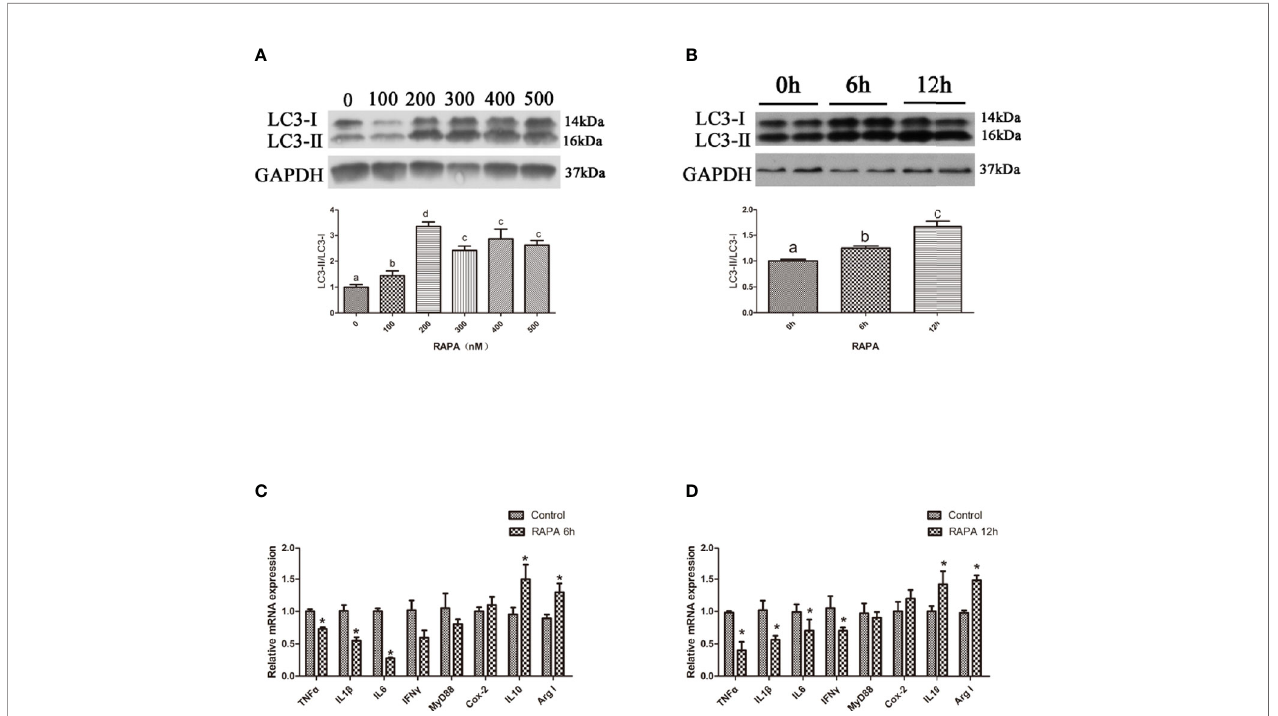
FIGURE 2 | Activation of autophagy could down-regulate the expression of in fl ammatory genes in vitro . (A) The ratio of LC3-II/LC3-I was analyzed by western blots in primary hepatocyte after treatment of different levels of RAPA (n=3). (B) The ratio of LC3-II/LC3-I was analyzed by western blots in primary hepatocyte after treatment of different time of RAPA (n=3). (C) The mRNA expressions of TNF a , IL1 b , IL6, IFN g , MyD88, Cox-2, IL10 and Arg I were analyzed by qRT-PCR in primary hepatocyte after treatment of 200 nM RAPA for 6h (n=6). (D) The mRNA expressions of TNF a , IL1 b , IL6, IFN g , MyD88, Cox-2, IL10 and Arg I were analyzed by qRT-PCR in primary hepatocyte after treatment of 200 nM RAPA for 12h (n=6). Results were represented as means with SEM and signi fi cance was evaluated by one-way ANOVA followed by Tukey ’ s multiple range tests or independent t tests (* P < 0.05). a,b,c Means share a same superscript letter are not signi fi cantly different ( P ≥